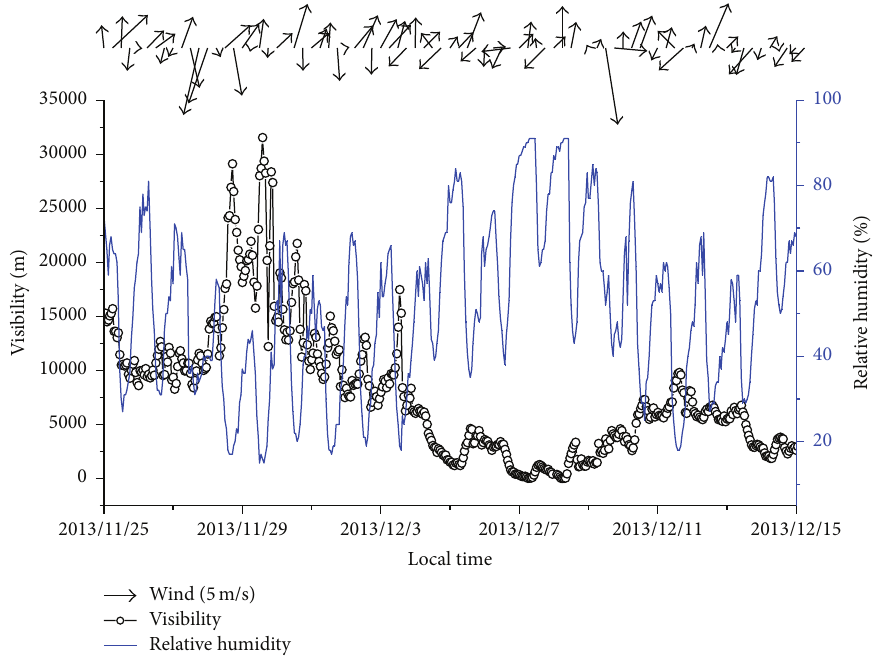
Figure 6: Hourly visibility, relative humidity, surface wind speed, and wind direction at Lin’an